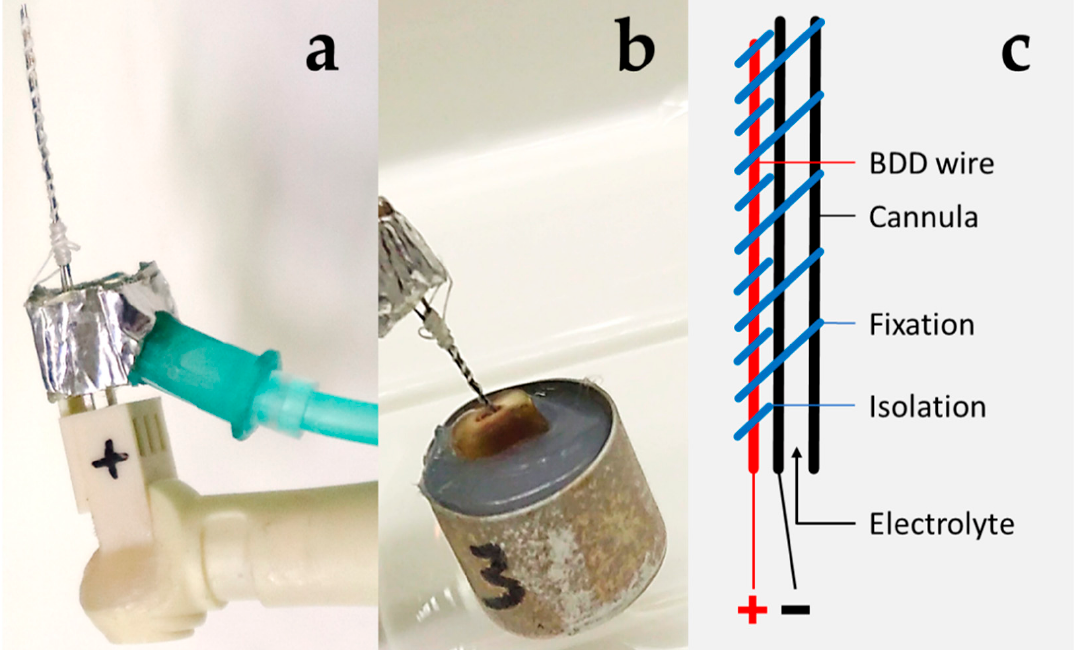
Figure 1. Determination of disinfection parameters using prototype 1. ( a ) Detailed view of prototype 1. A cannula for saline delivery was wired as cathode and combined with a BDD-coated niobium wire as anode. The handle seen on the left-hand side mimics a dental contra-angle and is used for connecting to a power and electrolyte source. ( b ) Application of prototype for disinfection of a root canal (extracted human tooth following crown removal at the cemento-enamel junction embedded in silicone). Note the saline flux from the root canal. ( c ) Scheme of electrode with anode (+) and cathode ( − ).